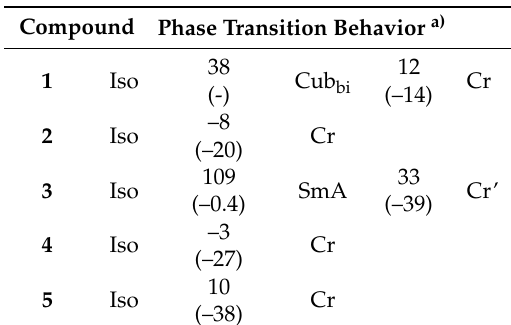
Table 1. Phase transition behavior of compound